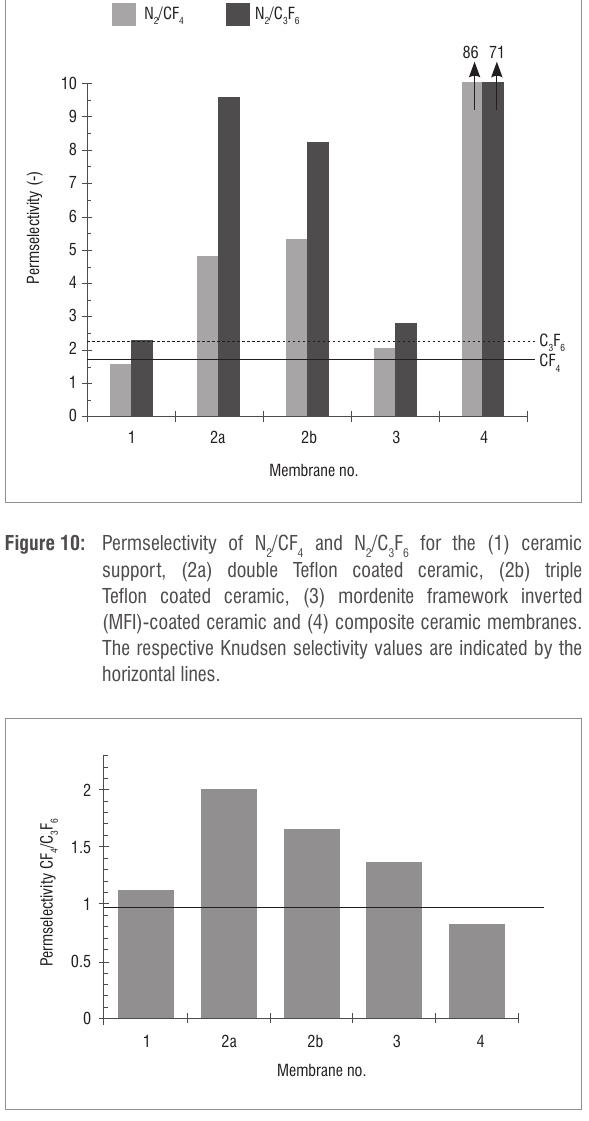
Figure 11: Permselectivity of CF double Teflon coated ceramic, (2b) triple Teflon coated ceramic, (3) mordenite framework inverted (MFI)-coated ceramic and (4) composite ceramic membranes. The respective Knudsen selectivity value for CF